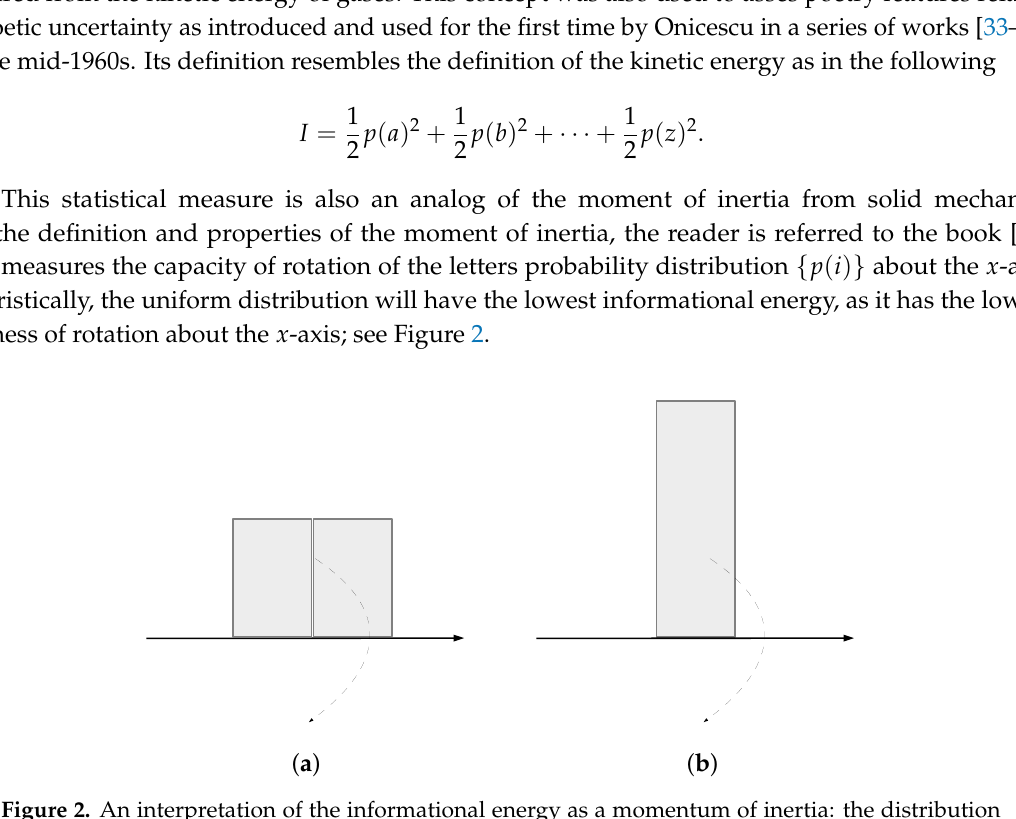
Figure 2. An interpretation of the informational energy as a momentum of inertia: the distribution ( a ) tends to rotate about the x -axis easier than distribution ( b ), so it has a smaller momentum of